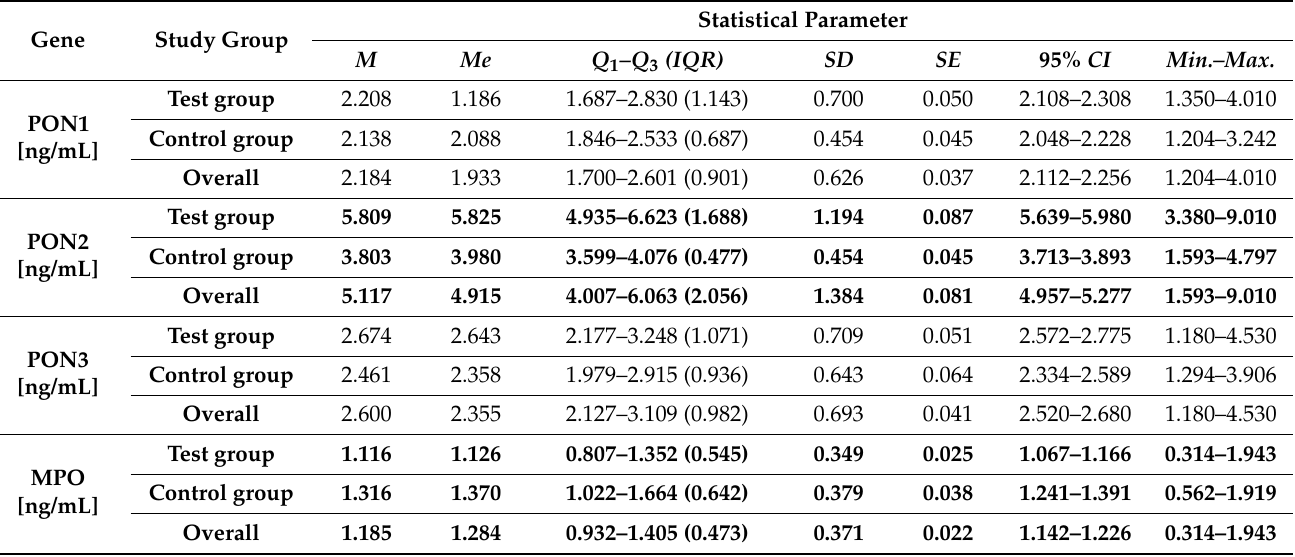
Table 3. Detailed descriptive statistics for protein concentrations (ng/mL) by study group.